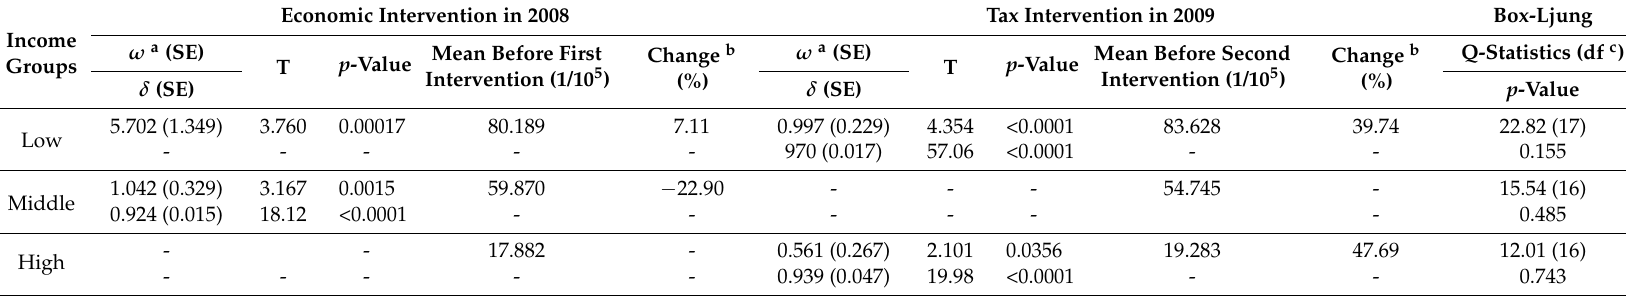
Table 2. Effects of the economic recession on monthly alcohol-attributed incident rates of hospitalization (per 100,000 persons) in working-aged men.